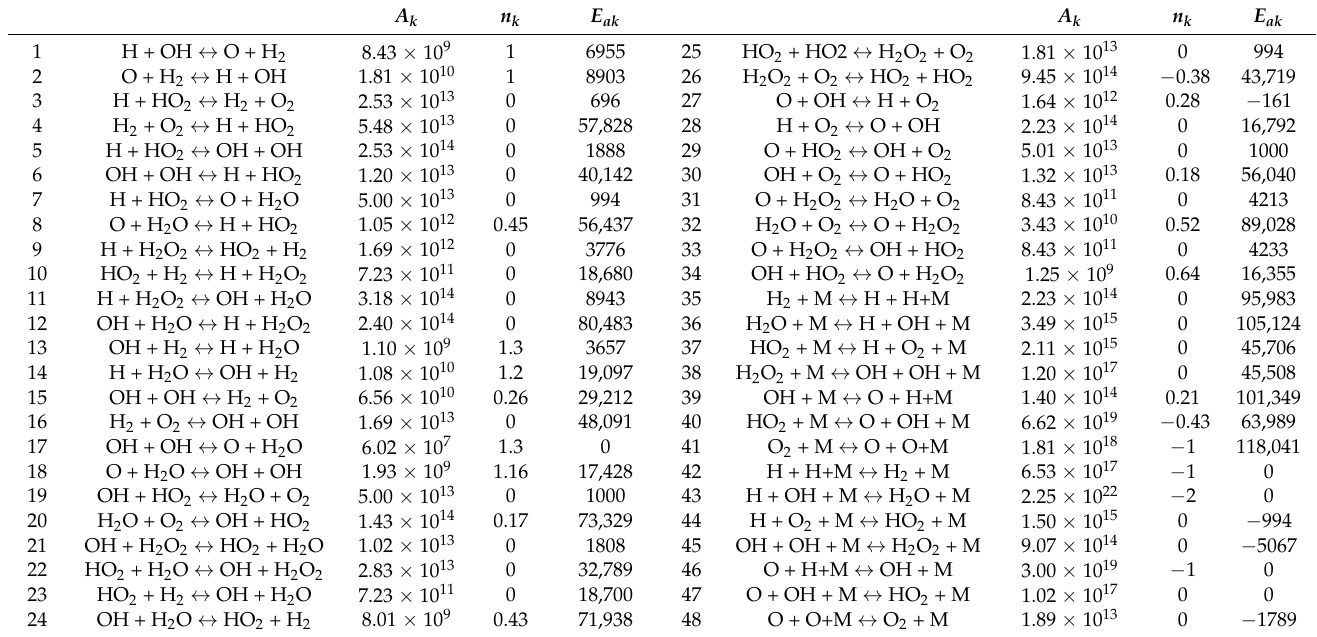
Table 1. Reaction mechanism and some related parameters (cm 3